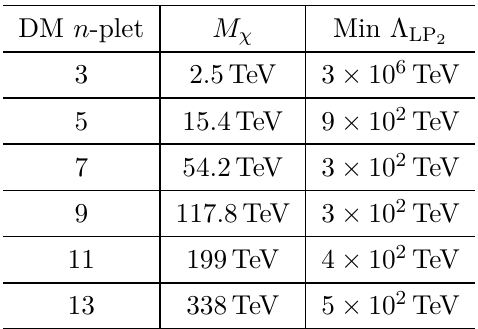
. In the running of the gauge 2